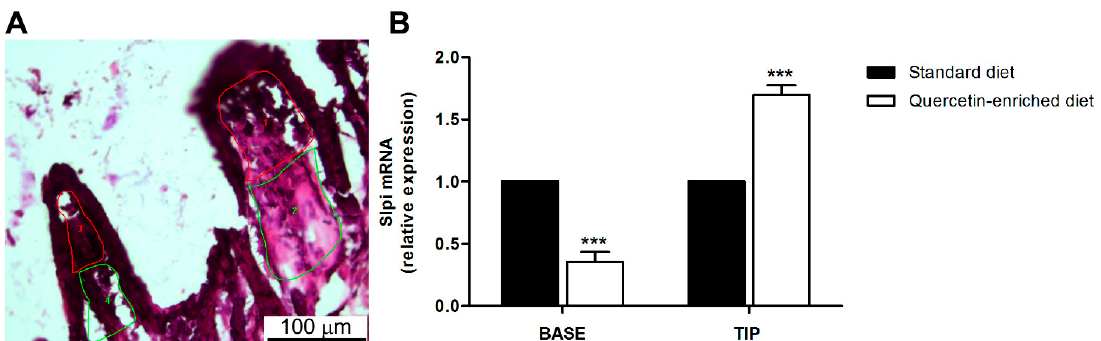
Figure 5. Quercetin induces Slpi expression in the tip of the intestinal villi. Animals were administered quercetin-enriched or standard diet for 4 weeks. ( A ) Representative image demonstrating captured lamina propria cells from the tip (red) or the base (green) of intestinal villi; ( B ) Lamina propria cells from standard (black bars) and quercetin (white bars) diet were laser-captured and Slpi expression measured by qPCR. Bars represent mean expression ± SEM ( n = 3) for each treatment. *** p < 0.001.